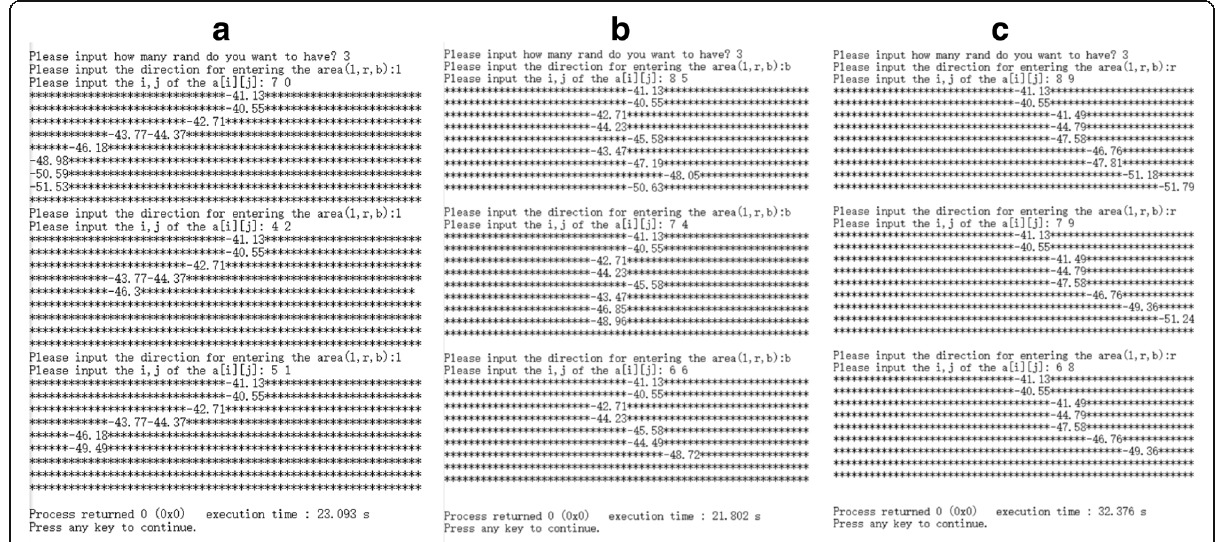
Fig. 14 Erob movement trajectory algorithm test ( a , b , c ). Erob enters the motion routing trajectory of the RFID positioning area from any three points: left side, bottom side, and right side. a Erob enters the target area ’ s trajectory from left side (left). Erob enters the routing path of the positioning area from any three points on the left side. b Erob enters the target area ’ s trajectory from bottom side (middle). Erob enters the routing path of the positioning area from any three points on the middle side. c Erob enters the target area ’ s trajectory from right side (right). Erob enters the routing path of the positioning area from any three points on the right side